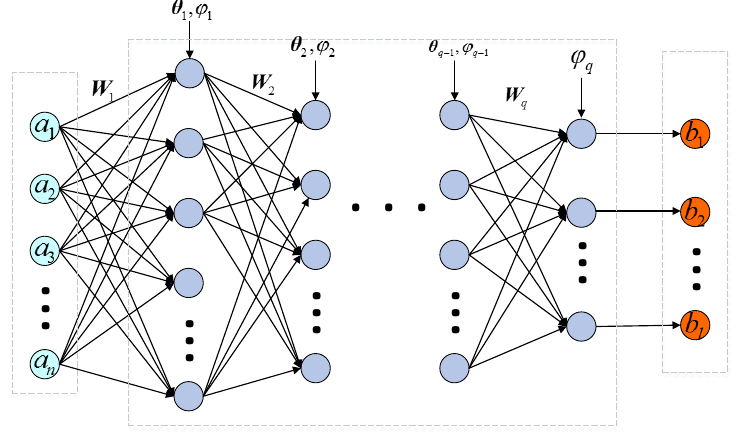
Figure 2. Deep neural network